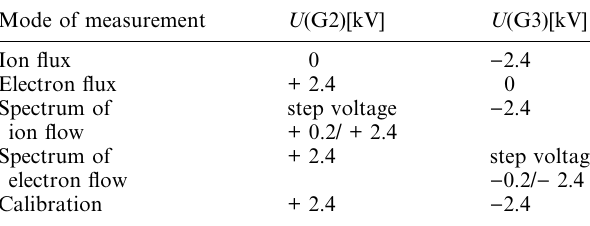
Table 1. G2 and G3 grid